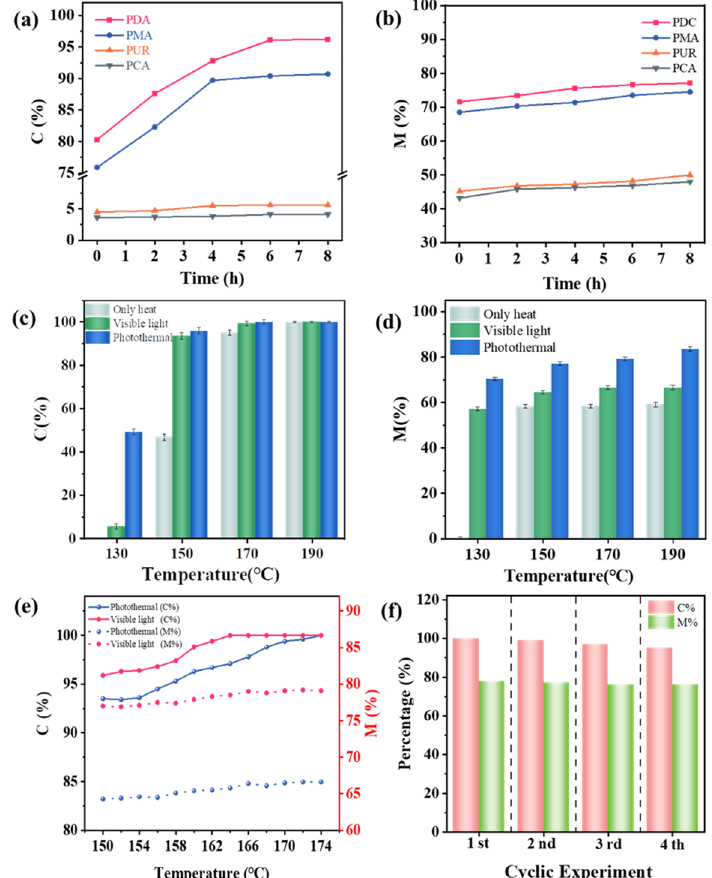
Figure 4. ( a ) Conversion rate, ( b ) mineralization rate of benzene by PDA, PCA, PMA and PUR under 150 °C and solar light conditions, ( c ) conversion rate, ( d ) mineralization rate of benzene for PDA under only heat, visible-light photothermal or solar light photothermal conditions, ( e ) conversion and mineralization rate of benzene for PDA under visible light or solar light photothermal conditions, ( f ) conversion/mineralization rate of four-cycle experiments of PDA under 162 °C and solar light conditions.